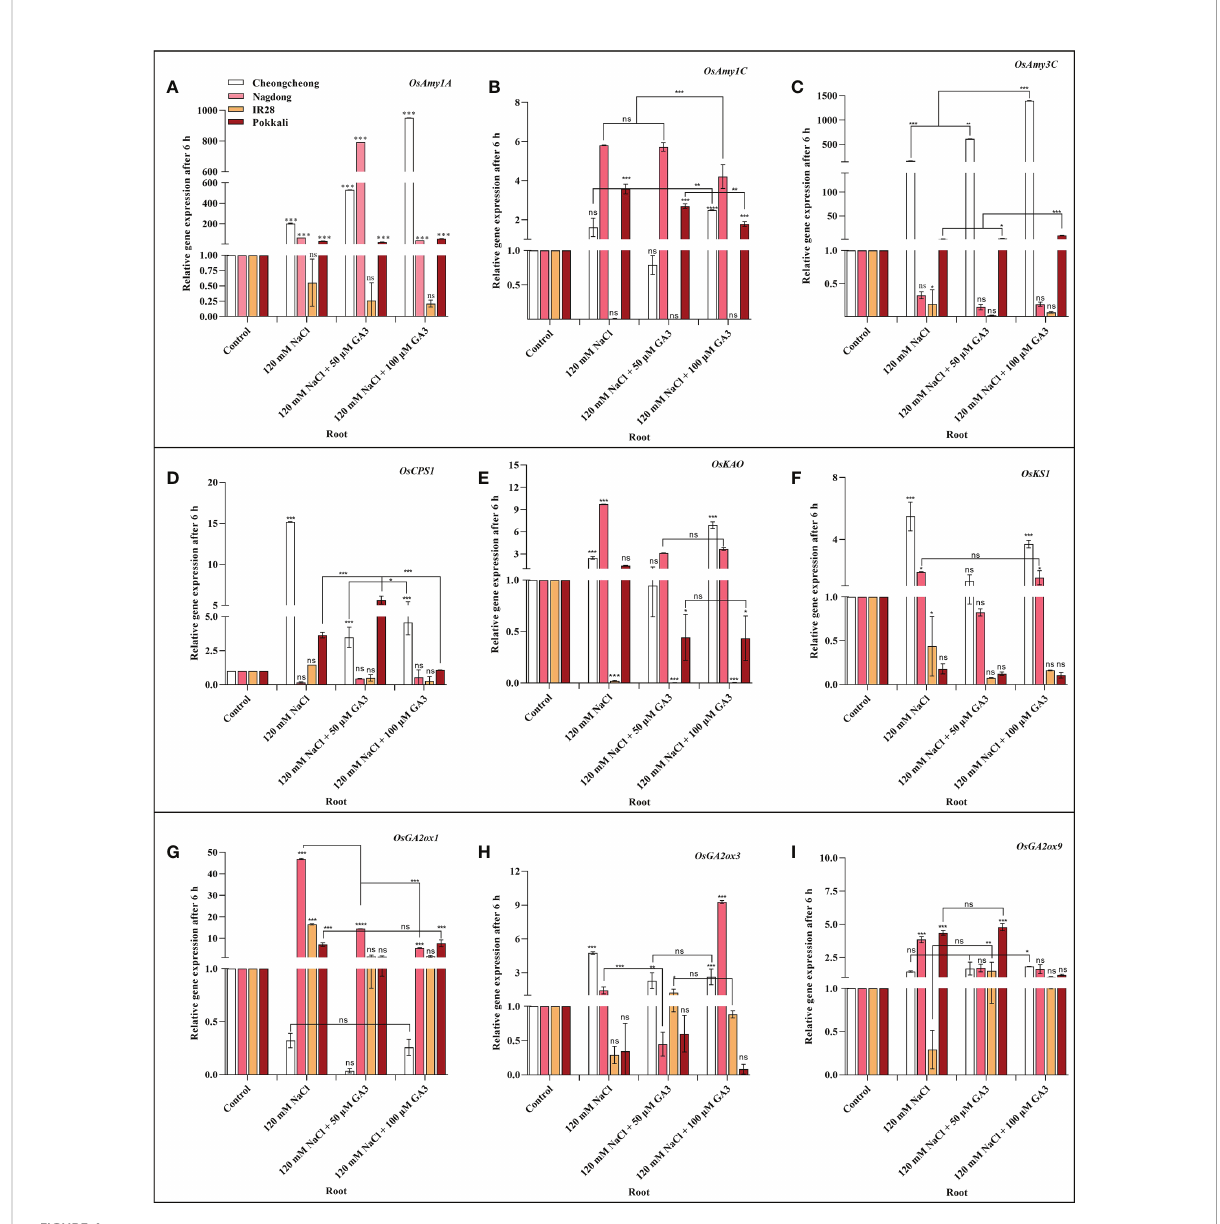
FIGURE 4 Effects of salt stress and exogenous GA3 application on a -amylase and GA metabolic gene expression in the roots of rice ( Oryza sativa L.) seedlings (A – I) . After 14-days incubation in distilled water, rice seedlings were treated with distilled water (control), 120 mM NaCl, or 120 mM NaCl + 50 or 100 µM GA3. After 6 h incubation, gene expression levels in the roots of the different rice cultivars were analysed. Data are presented as the mean ± SE, with gene expression levels given relative to the expression levels of a -amylase genes in the control group. Asterisks indicate a signi fi cant difference compared to control, analysed by Tukey ’ s multiple comparisons test. * P < 0.05, ** P < 0.01, *** P < 0.00; ns, not signi fi cant. GA, gibberellin; GA3, gibberellic